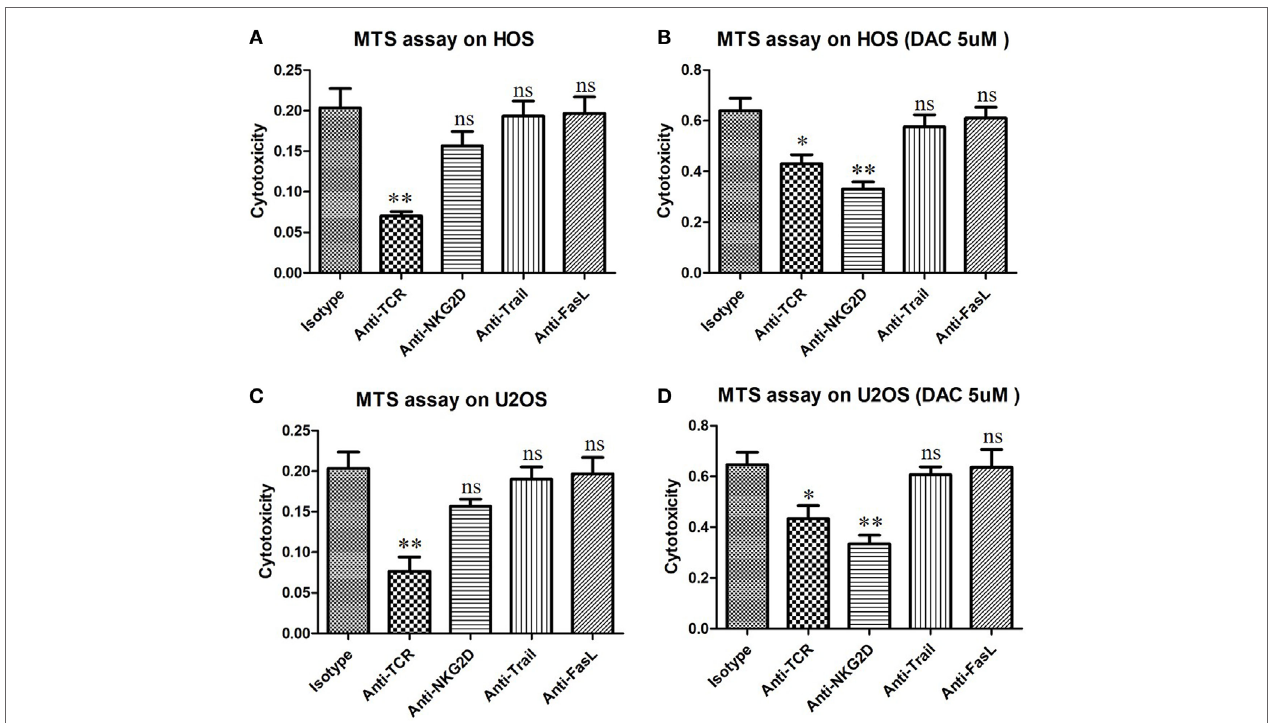
FigUre 6 | γδ T cells kill DAC-sensitized osteosarcoma (OS) cells mainly through the natural killer group 2D (NKG2D)–NKG2DL pathway. OS cells were pretreated with phosphate-buffered saline or decitabine (DAC) (5 µM) for 3 days. Then, γδ T cells were cocultured with DAC-pretreated OS cells for 4 h at an effector/target ratio of 5:1. Cytotoxicity of γδ T cells was determined using an MTS assay. γδ T cells were preincubated for 30 min with 10 µg/mL anti-human NKG2D, anti- pan- γδ T cell receptor (TCR), anti-Trail, or anti-FasL mAbs. Normally, TCR signal pathway was the key factor that can trigger the anti-OS activity of γδ T cells (a,B) . However, for DAC-pretreated OS cells, NKG2D–NKG2DL axis was the most important pathway by which γδ T cells killing about half of them (c,D) . Error bars show standard deviation among the replicates (* P < 0.05 vs. isotype control; ** P < 0.01 vs. isotype control; ns, no significance vs. isotype control. mAb, monoclonal